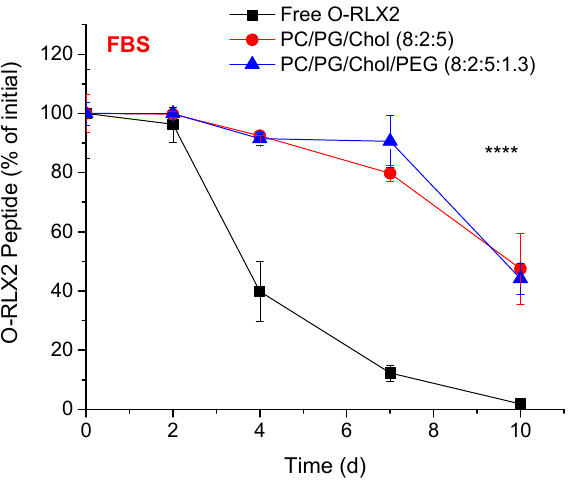
Figure 4. Stability of O-RLX2 peptide during incubation for 10 d at 37 ◦ C of free or liposomal peptide in the presence of PBS pH 7.40 ( A ), or in presence of FBS (80% v / v ) ( B ). All experiments were conducted at least 3 times, and the reported values are the mean values; bars represent the SD of each mean value. **** p < 0.0001.